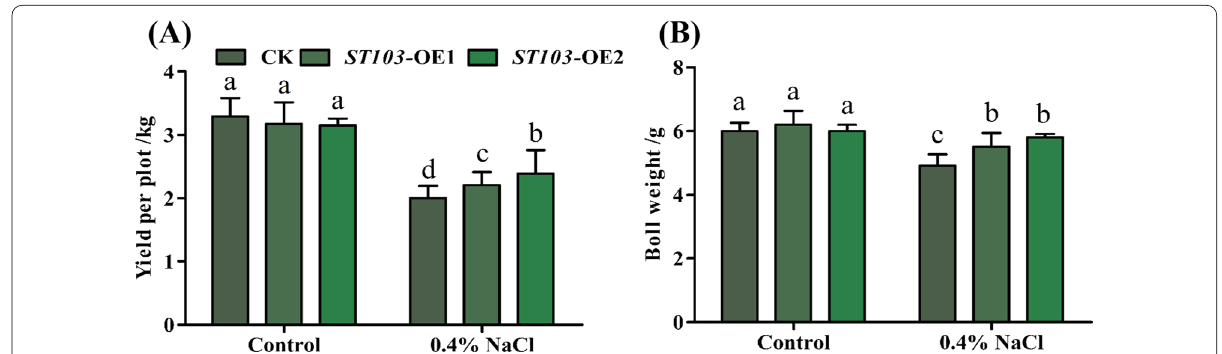
Fig. 3 The overexpression of ThST103 increases the cotton yield under saline conditions in field. A Yield of CK and transgenic cotton lines ( ST103- OE1 and ST103- OE2) under control and 0.4% NaCl conditions. B Average boll